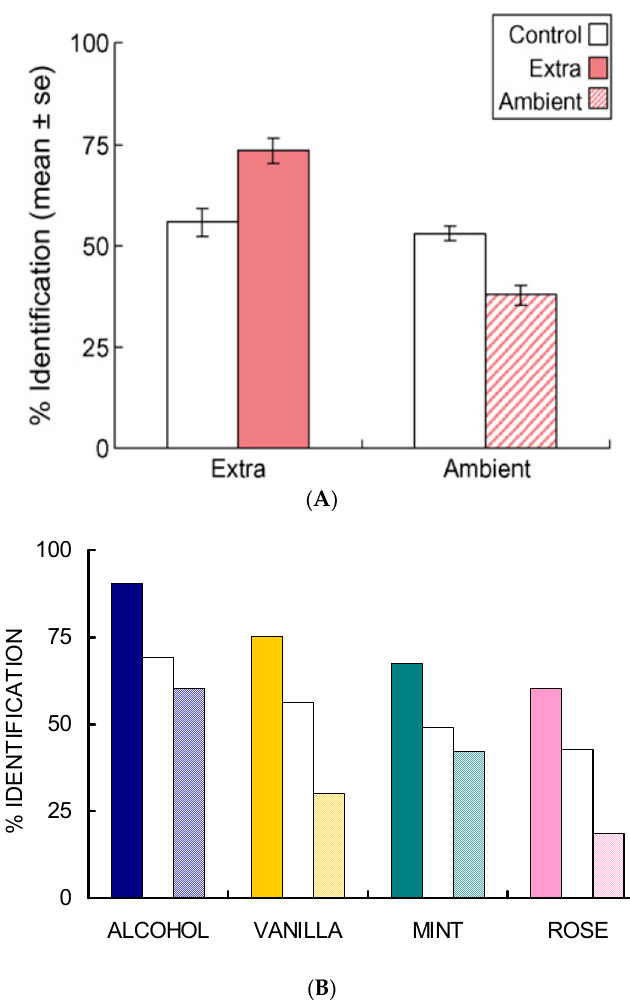
Figure 4. Selective adaptation of alcohol, vanilla, mint and rose odors in 2, 3, and 4 component mixtures. ( A ) Correct identification increased for newly introduced extra stimuli, p < 0.0001, but decreased for continuing ambient stimuli, compared to controls, p < 0.001. ( B ) Extra component identification is greater (solid color bars) and ambient component is poorer (striped color bars) than controls (white bars). From [26] with permission from Elsevier.